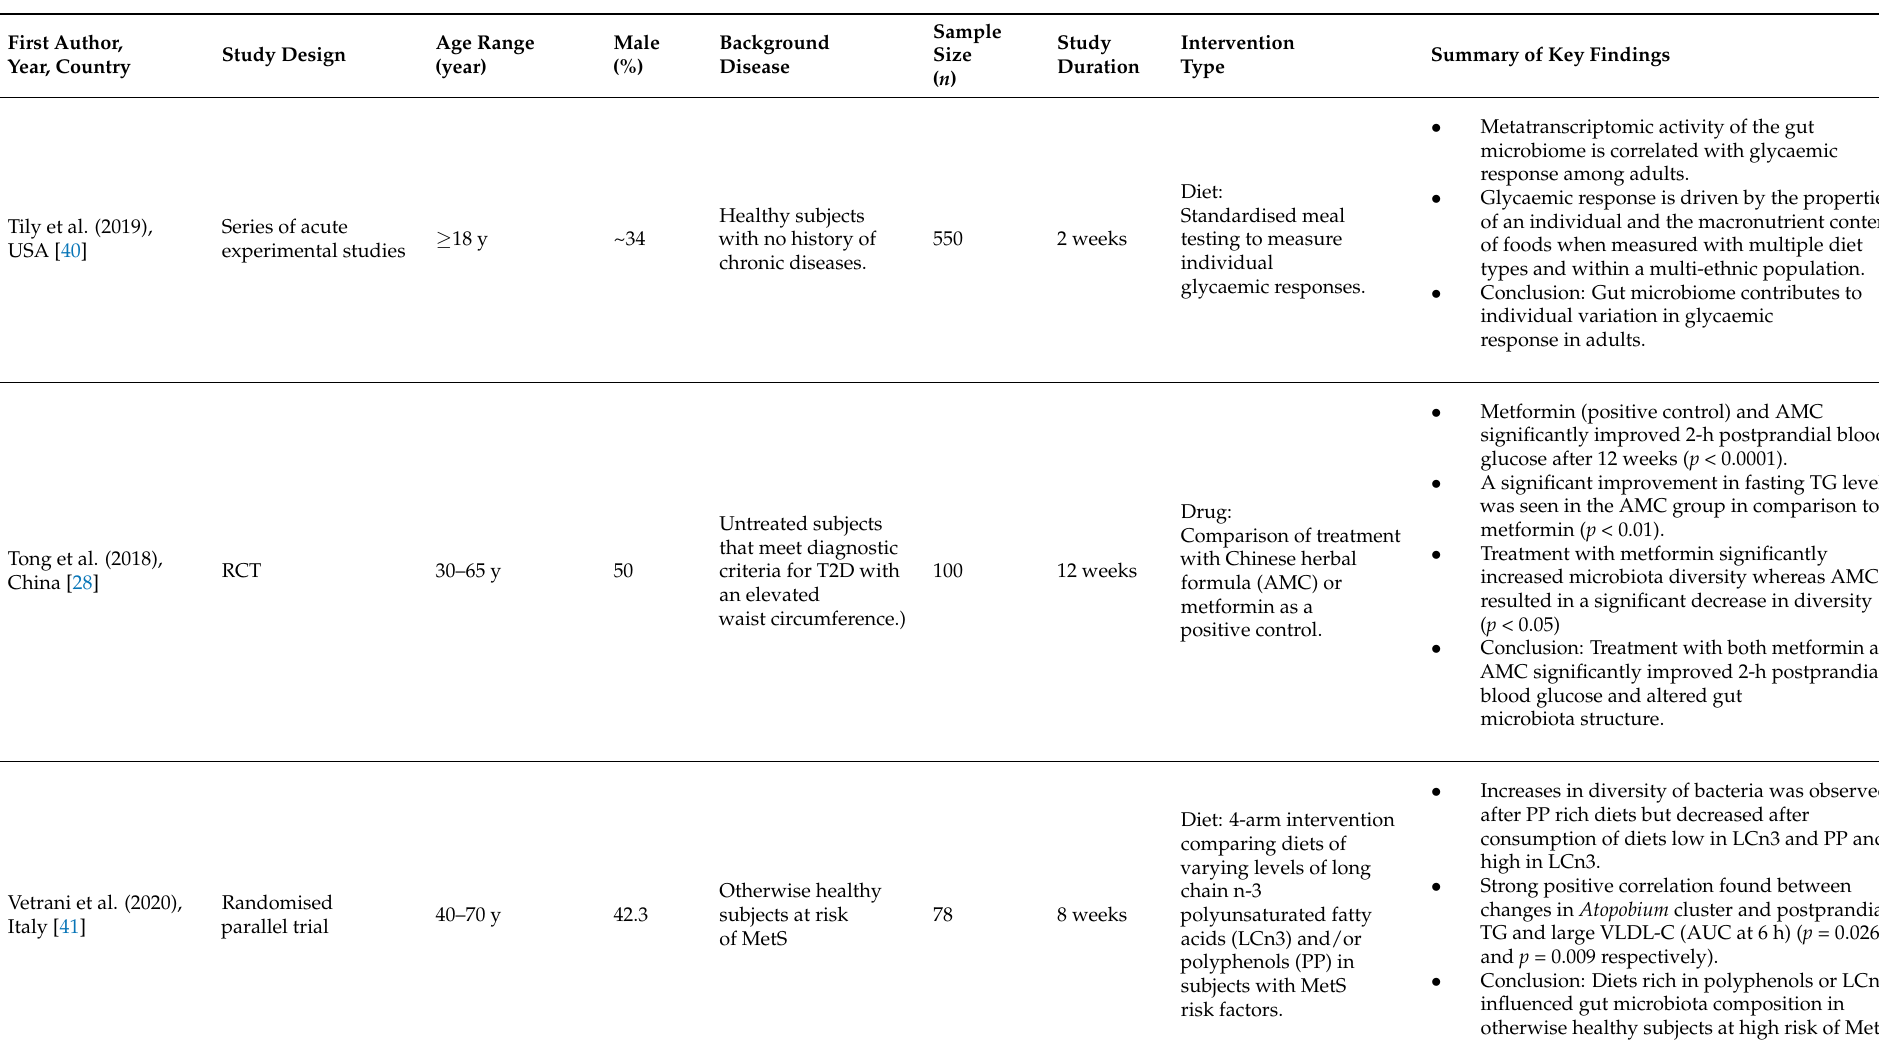
Diet: 4-arm intervention comparing diets